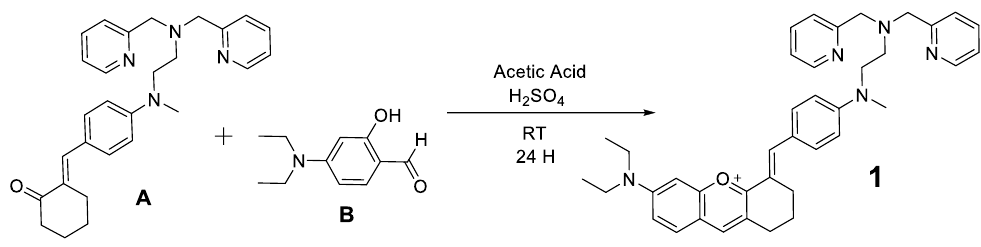
Figure 2. Synthesis reaction for styrylflavylium 1